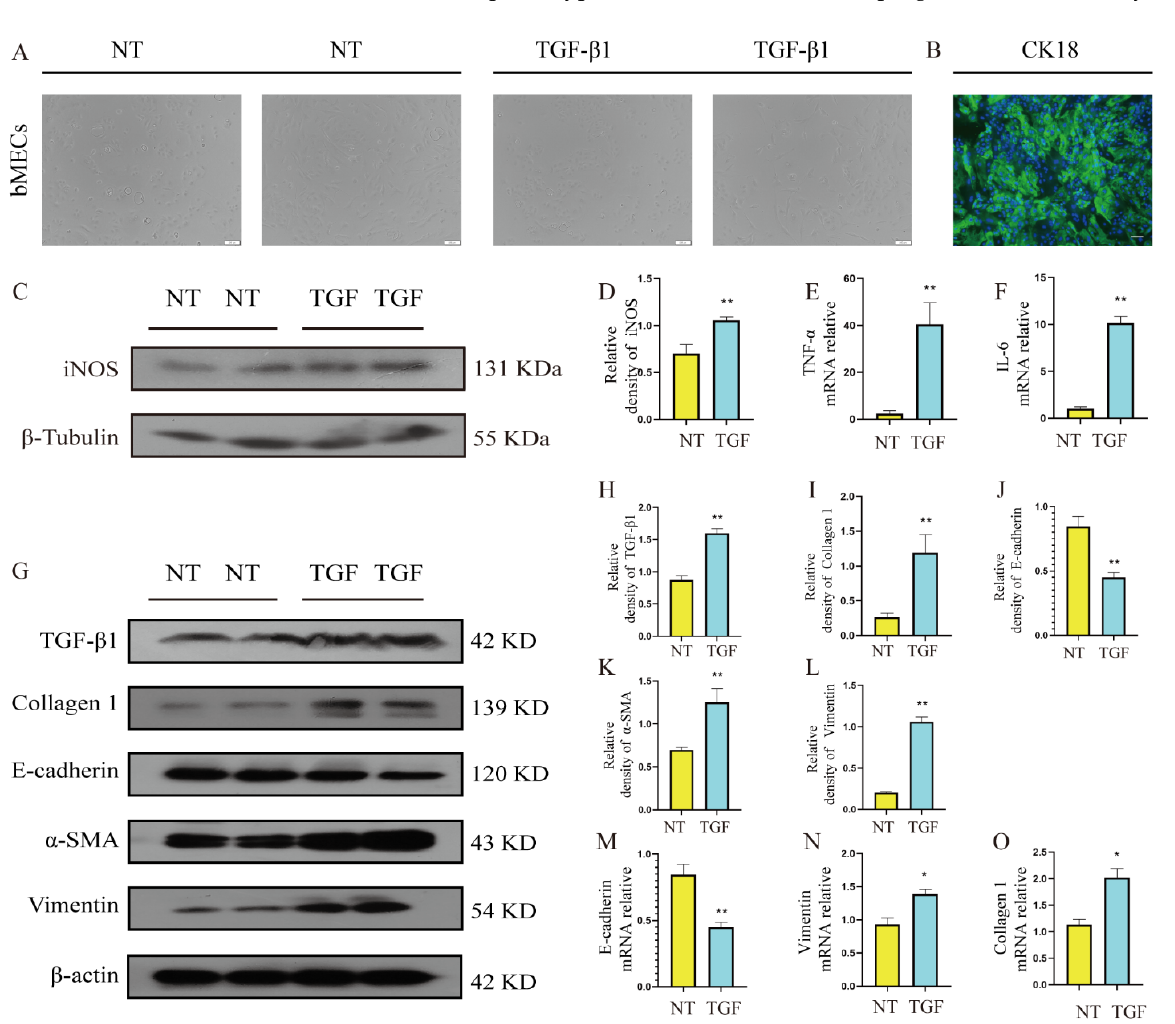
Figure 5. Changes of inflammatory and fibrotic phenotypes in TGF- β 1-induced bovine mammary epithelial cells (bMECs). TGF- β 1 was added to DMEM culture without FBS to stimulate bMECs for 48 h, and then the cells were collected for subsequent experiments. ( A ) The cell morphology of bMECs stimulated by TGF- β 1 for 48 h. ( B ) Immunofluorescence staining of CK18, a specific marker of bMECs, scale bar 50 μ M. ( C ) The protein levels of iNOS and β -actin in bMECs. ( D ) Quantification of iNOS protein levels in bMECs, relative to β -actin. ( E , F ) The mRNA expression levels of TNF- α , IL-6 in bMECs. ( G ) The protein levels of collagen 1, E-cadherin, α -SMA, vimentin and β -actin in bMECs. ( H – L ) The corresponding quantitative analysis of protein bands in ( G ). ( M – O ) The mRNA expression levels of E-cadherin, collagen 1, vimentin in bMECs. Data were analyzed by the unpaired t -test method. The data error is presented in the form of mean ± SEM. The results of the experiment are the result of three independent repeated experiments. * p < 0.05, ** p < 0.01 compared with the control group.